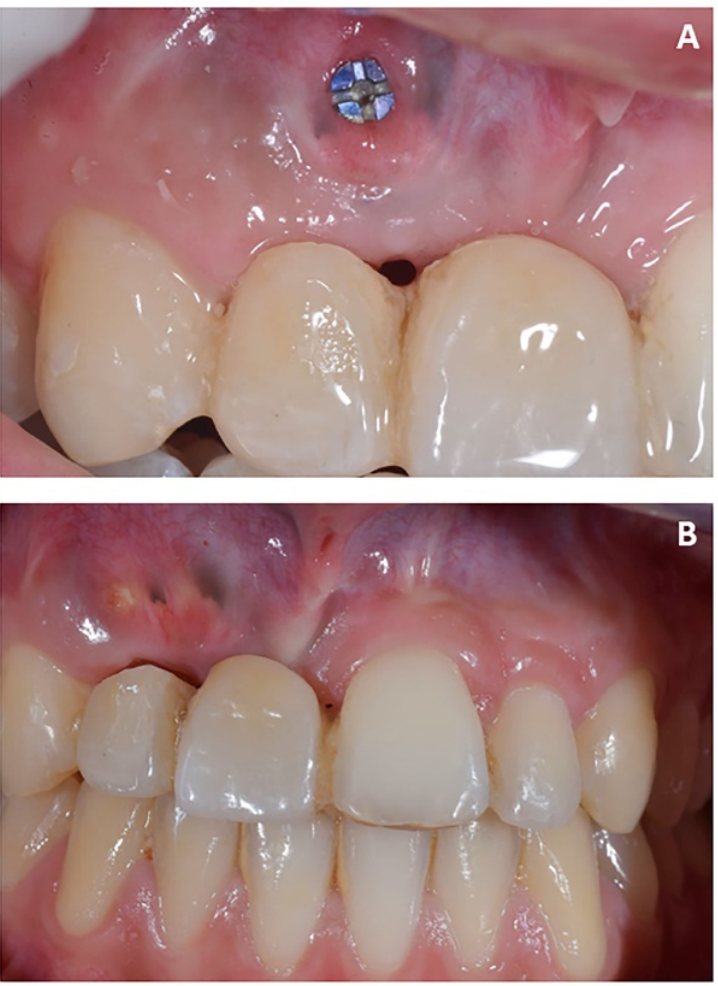
Figure 8. Case 2. Pre-treatment condition. ( A ) Maryland with fiberglass and resin teeth, repaired several times and interfering with proper maneuvers of oral hygiene; ( B ) absence of soft-tissue inflammation after oral hygiene and scaling.